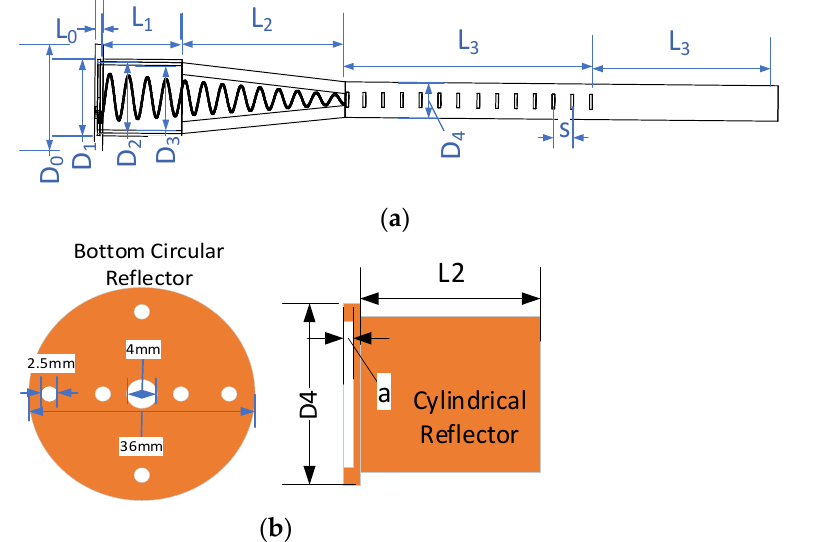
Figure 8. ( a ) Parametric description of the proposed antenna structure ( b ) Layout of metal reflec- tor. Table 1. Dimension parameters of the proposed structure.